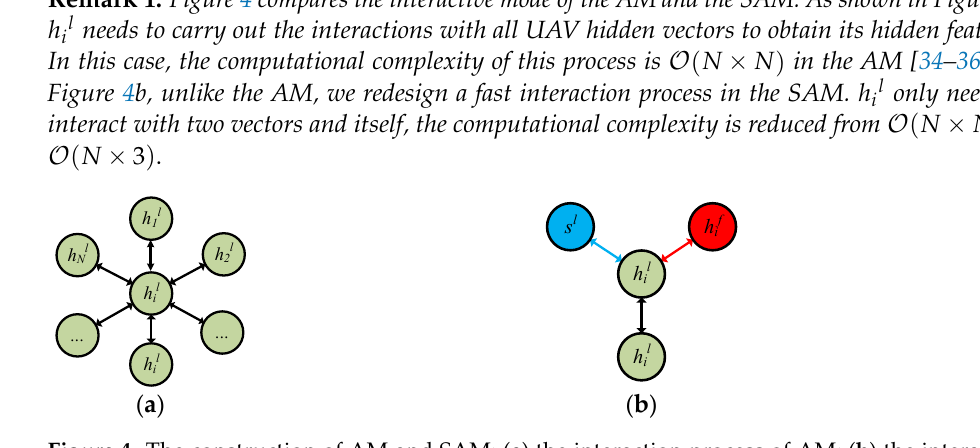
Figure 4. The construction of AM and SAM: ( a ) the interaction process of AM; ( b ) the interaction process of SAM.